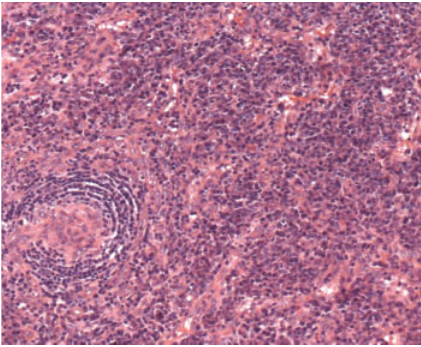
Figure 2: High power view of the node with plasma cell variant of castlemans.